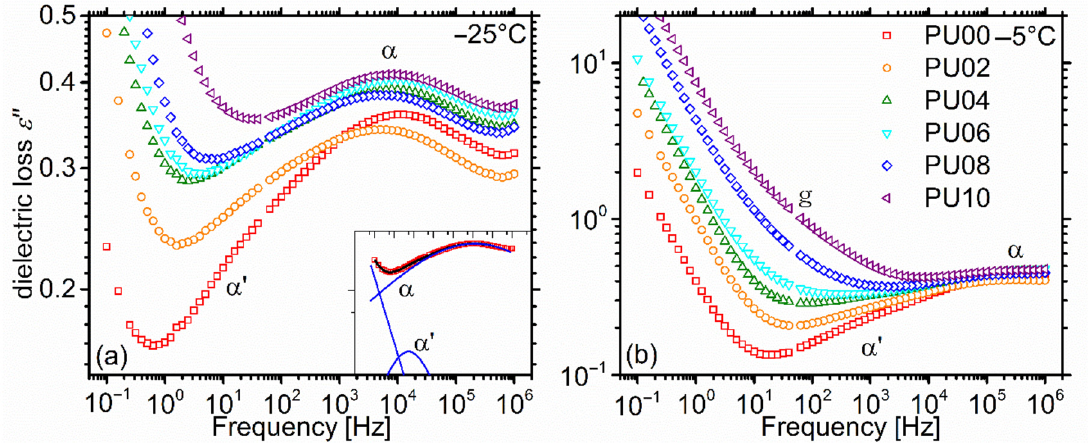
Figure 10. Dielectric loss ε (cid:48)(cid:48) spectra recorded with all materials at ( a ) − 25 ◦ C, and ( b ) − 5 ◦ C. Lines are fits according to the procedure described in text. The constituting functions for the spectrum of the matrix at − 25 ◦ C are shown in the inset of panel ( a